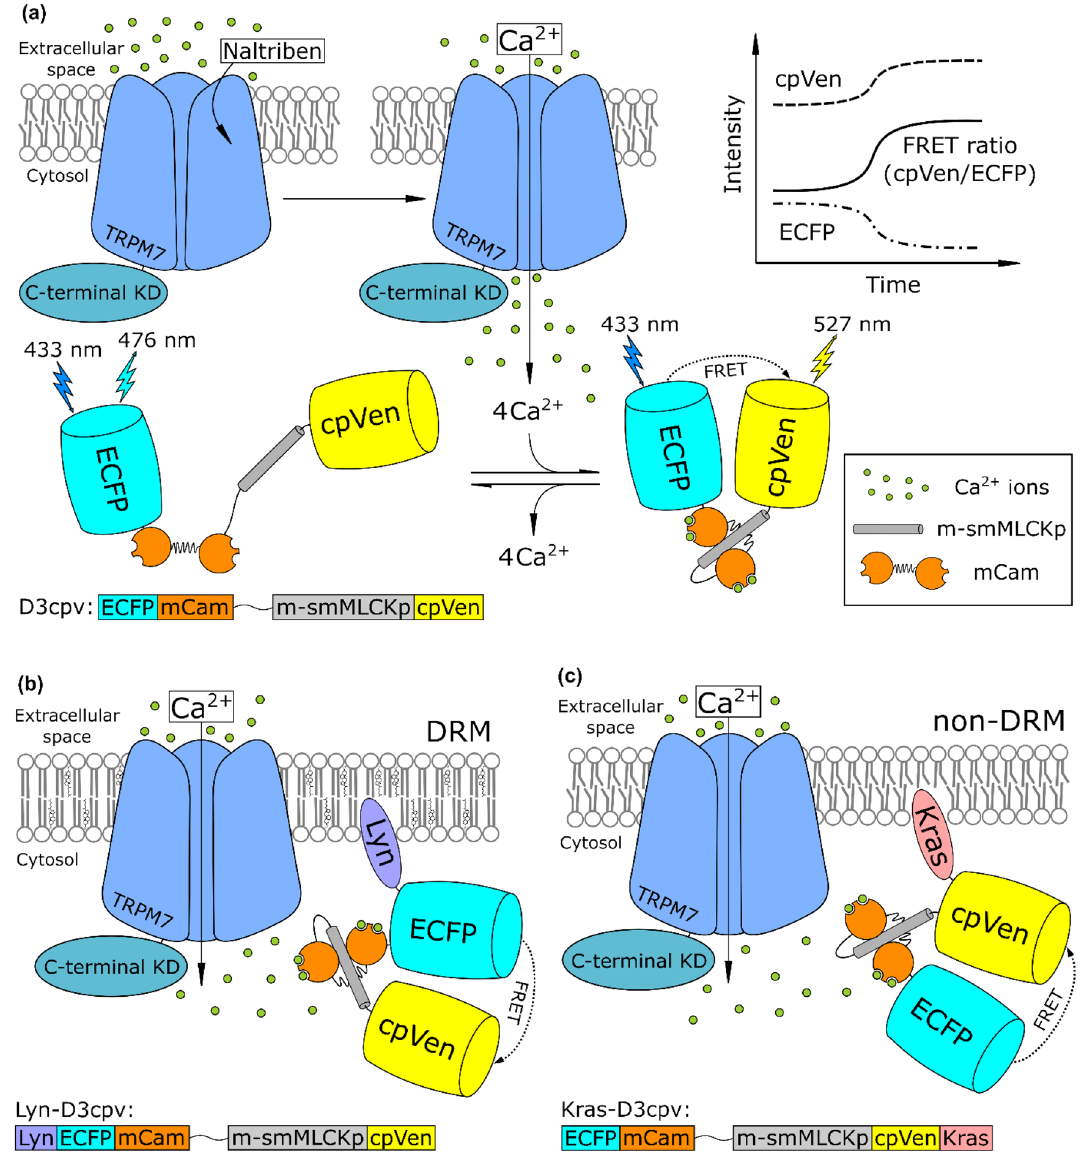
Figure 1. Schematic representation of the experiment. The local Ca 2+ concentration increased after transient receptor potential subfamily M member 7 activation with naltriben and ( a ) the cameleon biosensor D3cpv changed its conformation in the presence of Ca 2+ ions resulting in fluorescence resonance energy transfer (FRET) ratio change. Conformational change occurs due to Ca 2+ binding to mutated calmodulin (mCam) and consequent interaction of this complex with mutated smooth muscle myosin light chain kinase peptide (m-smMLCKp). ( b ) Lyn-D3cpv contains the lyn kinase acylation substrate sequence at the N-terminus, (c) and a prenylation substrate sequence from KRas is fused with the C terminus in Kras-D3cpv, which causes tethering of the biosensors to detergent-resistant membrane (DRM) and non-DRM. Figures from several studies were used as a reference for the preparation of this figure 19,25–31 . KD, kinase